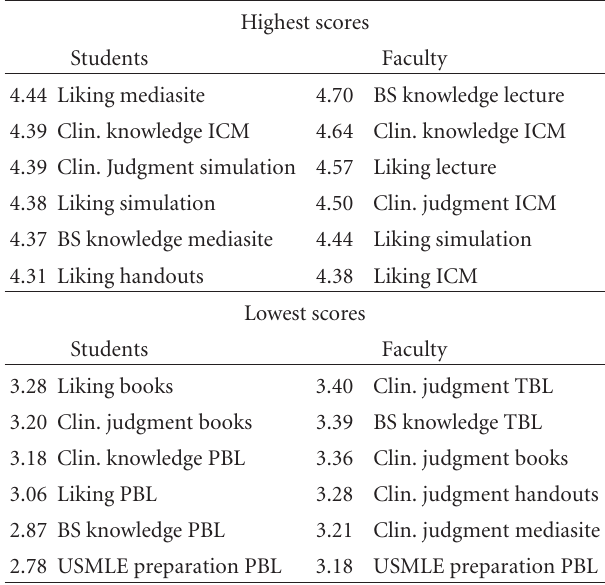
Table 1: Highest and lowest scores on the questions in the questionnaires, separately for students and faculty. N = 267–326 students and 13–30